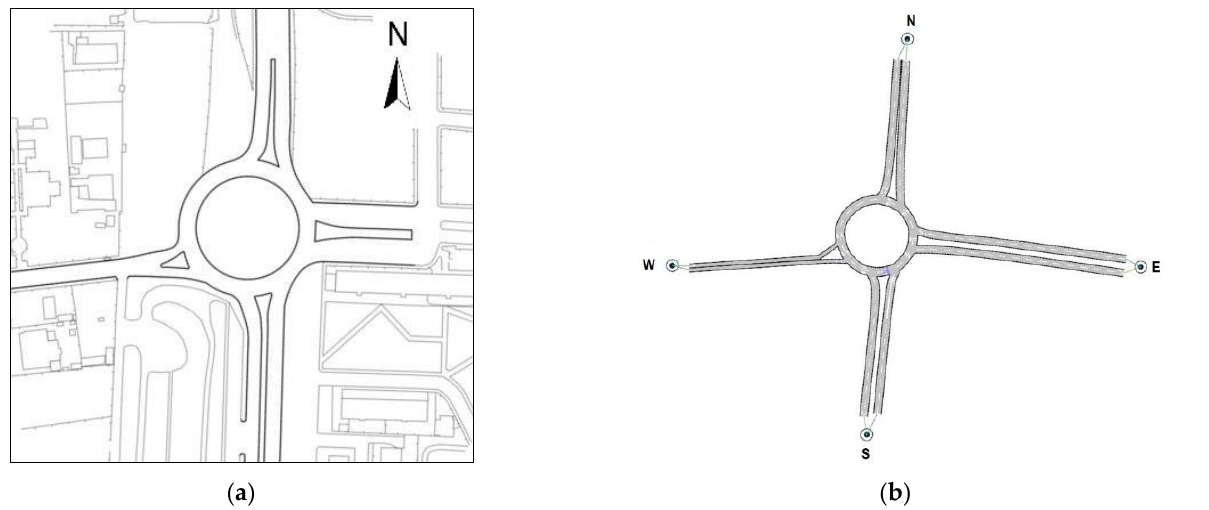
Figure 4. The two-lane roundabout (roundabout 2): ( a ) the sketch of the roundabout; ( b ) the network model built in Aimsun Next with labels for the centroids (N: North; S: South; E: East; W: West). Traffic flow data were collected both manually and videotaped on each entry (and exit) during the morning peak (from 8:00 am to 9:00 am) and afternoon peak (from 7 pm